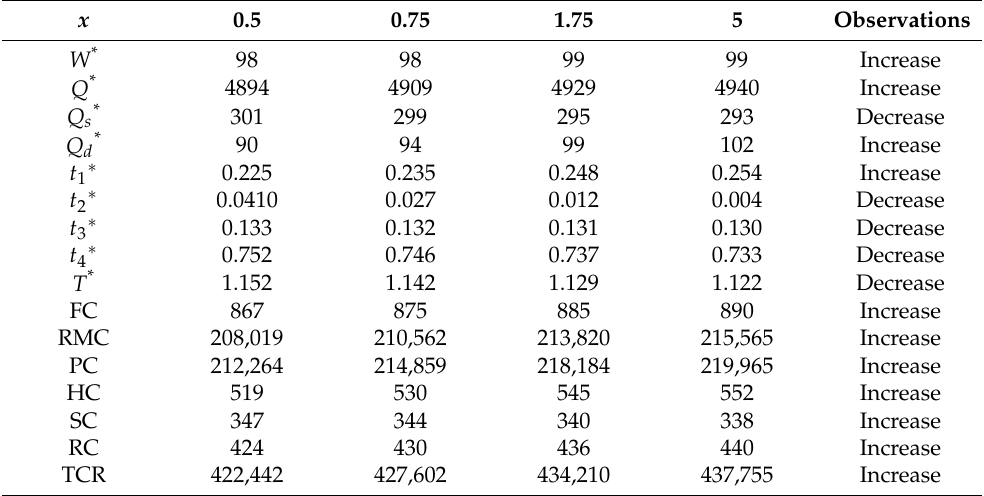
Table 2. Sensitivity of “ x ” to different decision variables and costs. The static input values of the